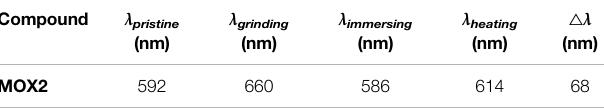
TABLE 2 | Peak emission wavelengths (nm) of solid-state MOX2 under different conditions.